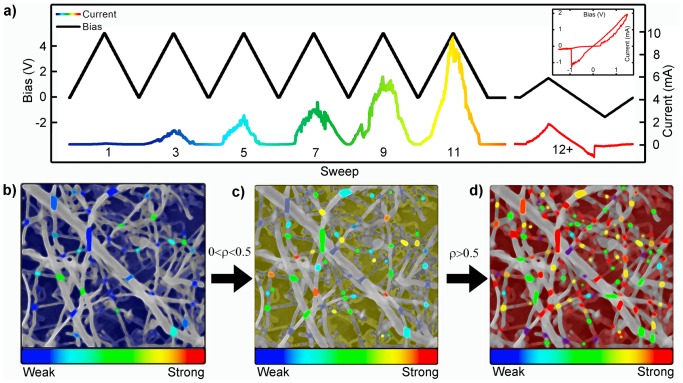
Network Activation - memristive behavior.(a) Representative example of initial bias sweeps (0–5 V sweep at 1 V/s) applied to a pristine device which steadily activate higher percentages of atomic switches, resulting in increased current. After 11 sweeps, the device resistance decreases from ∼10 MΩ to ∼500 Ω. Subsequent ±1.5 V bipolar sweeps result in repeatable pinched hysteresis behavior (inset: ROFF = 25 kΩ, RON = 800 Ω), and bistable switching. (b–d) Schematic representation of the mechanism producing the I–V characteristics shown in (a). The network initially consists of weakly memristive junctions and ohmic contacts (b). Continued application of unipolar bias voltage (c) drives the dissolution of silver into silver sulfide, increasing the number of memristive elements, while cation migration across extant memristive junctions leads to filament formation and the onset of hard switching behavior. (d) After the proportion of strong memristors exceeds the percolation threshold (ρ>0.5), the network functions reliably in the hard switching regime.